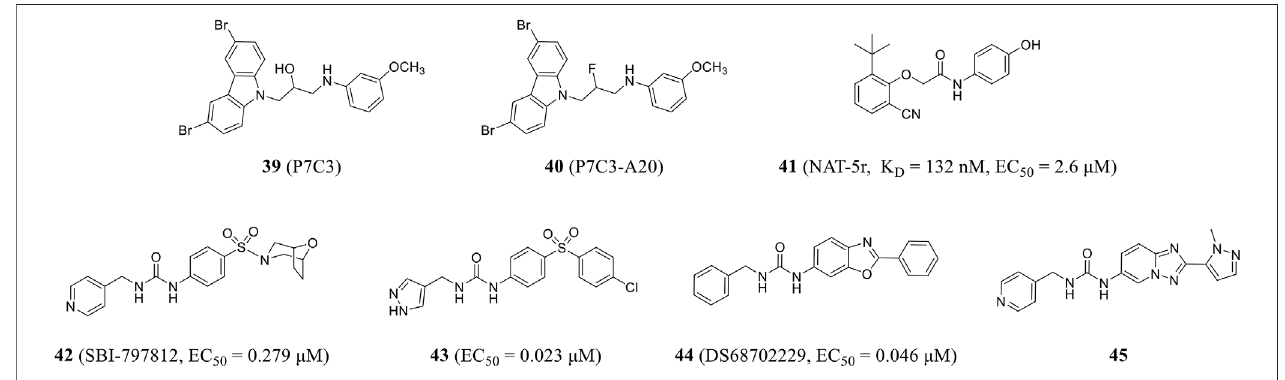
FIGURE 10 | Chemical structures and kinase activities of NAMPT agonists 39 – 45